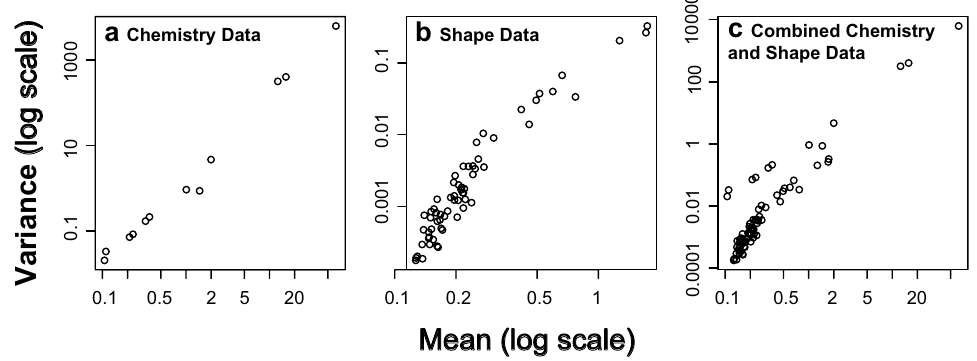
Figure 1. Mean–variance plots showing non-linear relationships for ( a ) the otolith chemistry dataset, ( b ) the otolith shape dataset, and ( c ) the combined otolith chemistry and shape dataset. Note the log scale on both